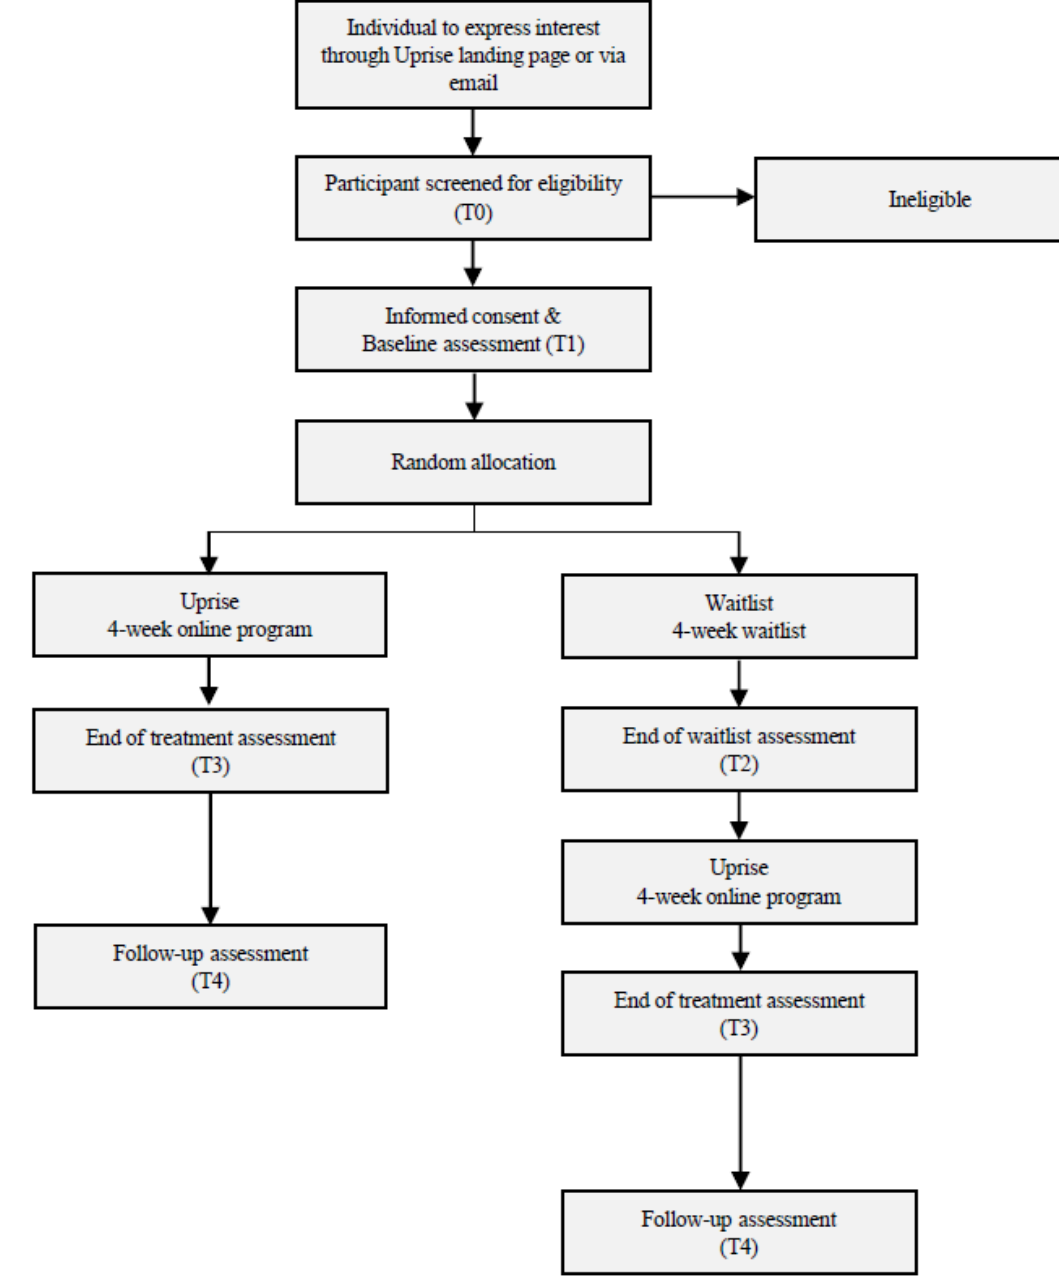
Figure 1. Consolidated Standards of Reporting Trials (CONSORT) diagram showing the trial